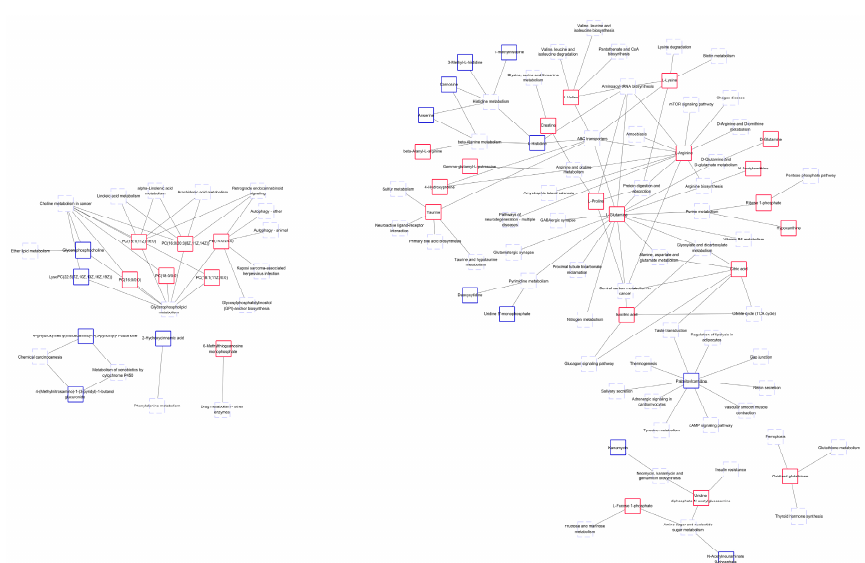
Figure 8. Metabolic pathways and metabolite network diagram. The red box means the metabolite with high content in BM, the green box means the metabolite with low content in BM (compared with DB), and the light-dotted boxes represent metabolic pathways. BM: Bama xiang pig, DB: Debao pig.